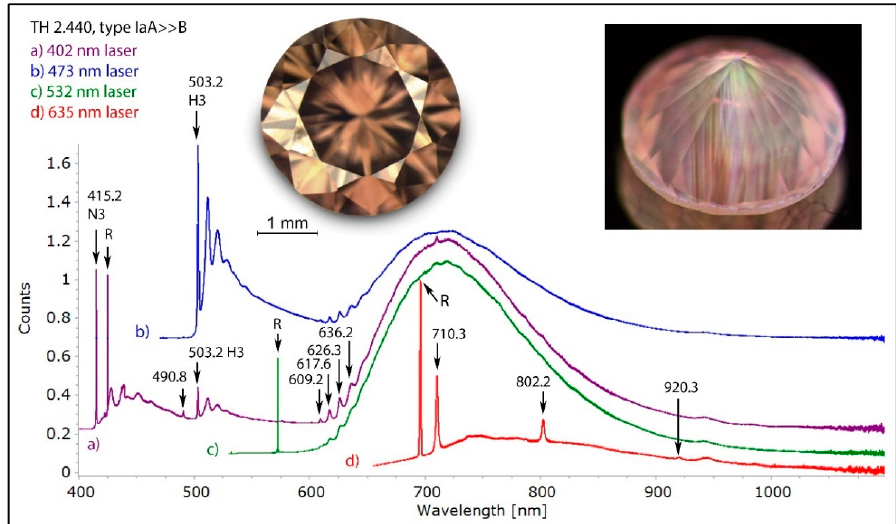
Figure 14. The low temperature PL spectra of a pinkish brown type IaA>>B diamond with a deformation-related color, recorded with four different lasers. Besides the omnipresent H3 defect and the 490.8 nm defect, the most characteristic band seen in most of such diamonds is the 617.6/626.3 nm defect with its associated broad vibronic band centered approximately at 720 nm. This defect is responsible for the pink fluorescence seen in the diamond under DFI 340 nm excitation (photo inset, right). The spectra were shifted vertically for clarity.